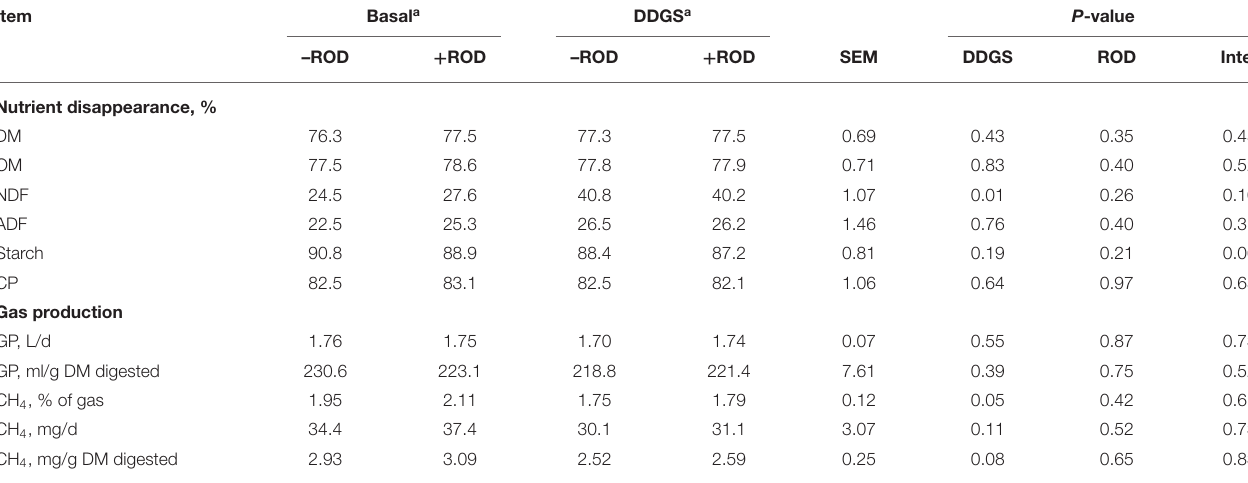
TABLE 3 | Effect of wheat DDGS and the ROD extract on nutrient disappearance and gas production (GP) in RUSITEC. Item Basal a DDGS